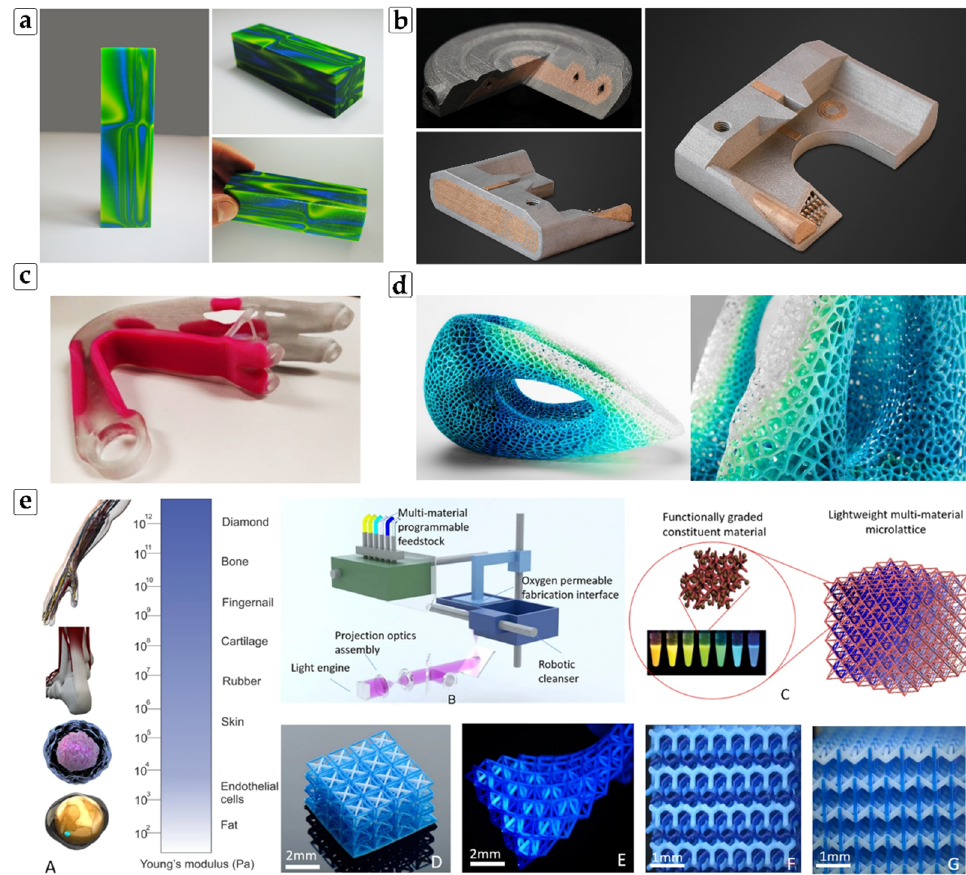
Figure 2. ( a ) Volumetric gradient pattern of VeroCyan and VeroYellow polymer materials fabricated by the Stratasys PolyJet J750, reproduced with permission from [33], ( b ) dual-metal copper parts created using Aerosint’s recoater, photo by Aerosint, reproduced with permission from [34], ( c ) multi-material part generated by the Paramatters software and fabricated by the AM technology, reproduced with permission from [35], ( d ) 3D-printed multi-material lattice chair fabricated by the Stratasys Object 500 Connex3 with gradient material interfaces, image adopted from [36], ( e ) fabrication of 3D multi-material microlattice with dissimilar constituent materials. Images were reprinted for free with no permission required under http://creativecommons.org/licenses/by/4.0 / through article (accessed on 15 December 2021) [37].